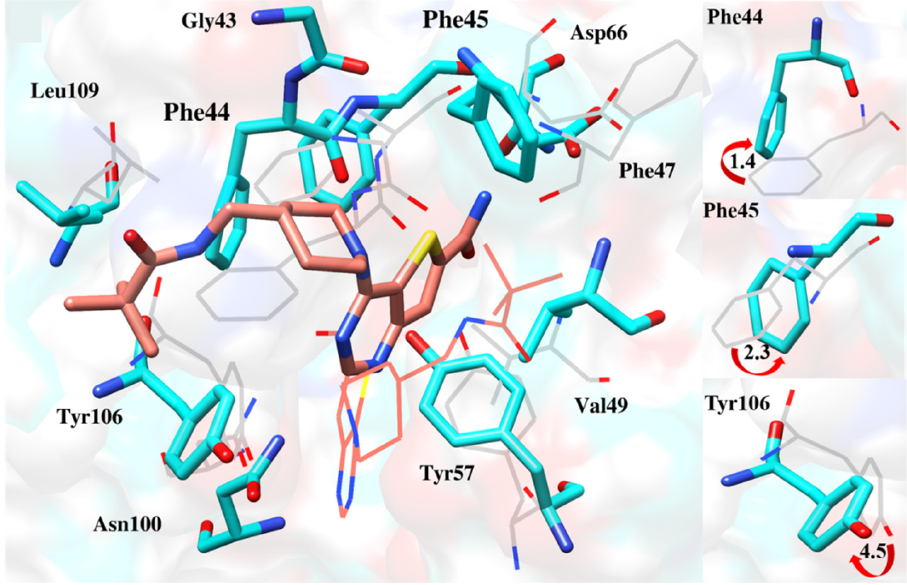
Figure 17. Deflection of Phe44, Phe45 and Tyr106 to accommodate ZINC95589781 deeper inside the pocket [17].